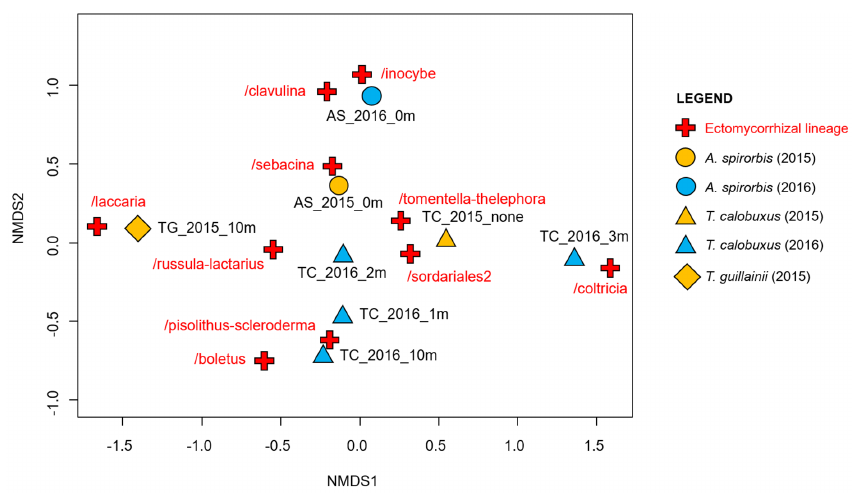
Figure 6. Non-metric multidimensional scaling representation of the ectomycorrhizal lineages (red cross and text) found in all samples. Hosts are symbolized as follows: A . spirorbis with circles, T . calobuxus with triangles, and T . guillainii with a diamond. Two different years of sampling (2015 and 2016) are indicated in blue and orange, respectively.